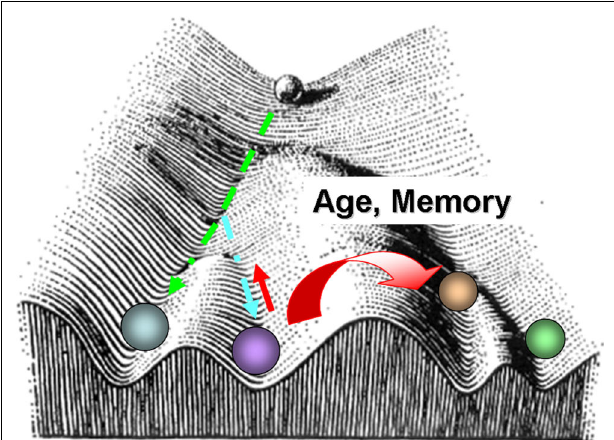
FIGURE 9 | Waddington type landscape superposed with the distinct epigenetic trajectories for different neuronal types as a function of aging. The landscape diagram is modifi ed from Waddington, C. H., 1956 (Principles of Embryology, op. cit., p. 412). Following Waddington’s visual schematics, the ball represents a neuronal fate. The valleys are the different fates a given neuron might roll into. At the beginning of its journey, development is plastic, and a cell can have many fates. However, as development and aging proceeds, certain molecular events occur randomly and this can lead to different underlying molecular phenotypes and decisions that cannot be